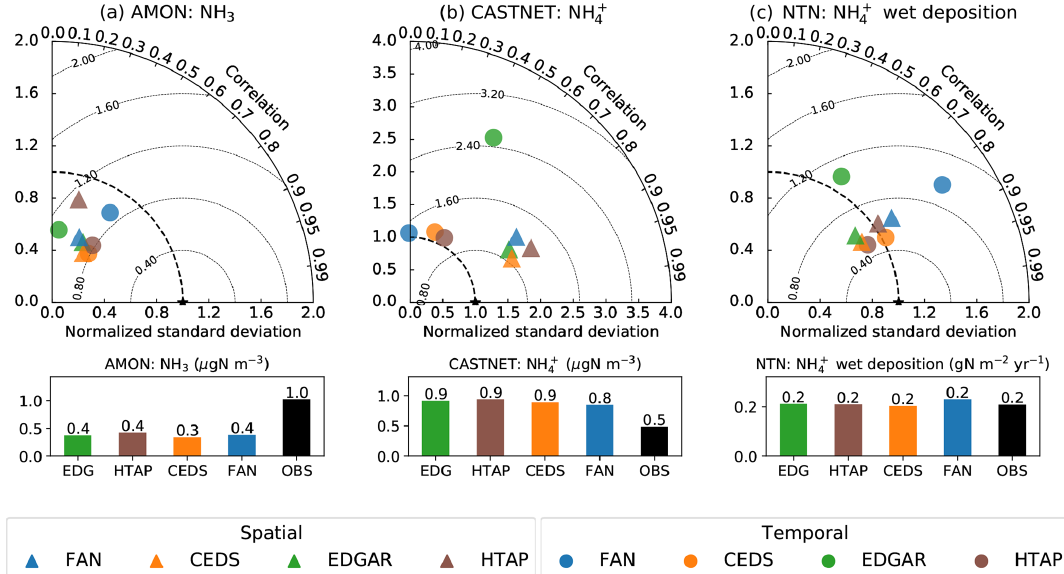
+ (b) concentrations and the NH + wet deposition (c) evaluated for the 4 4